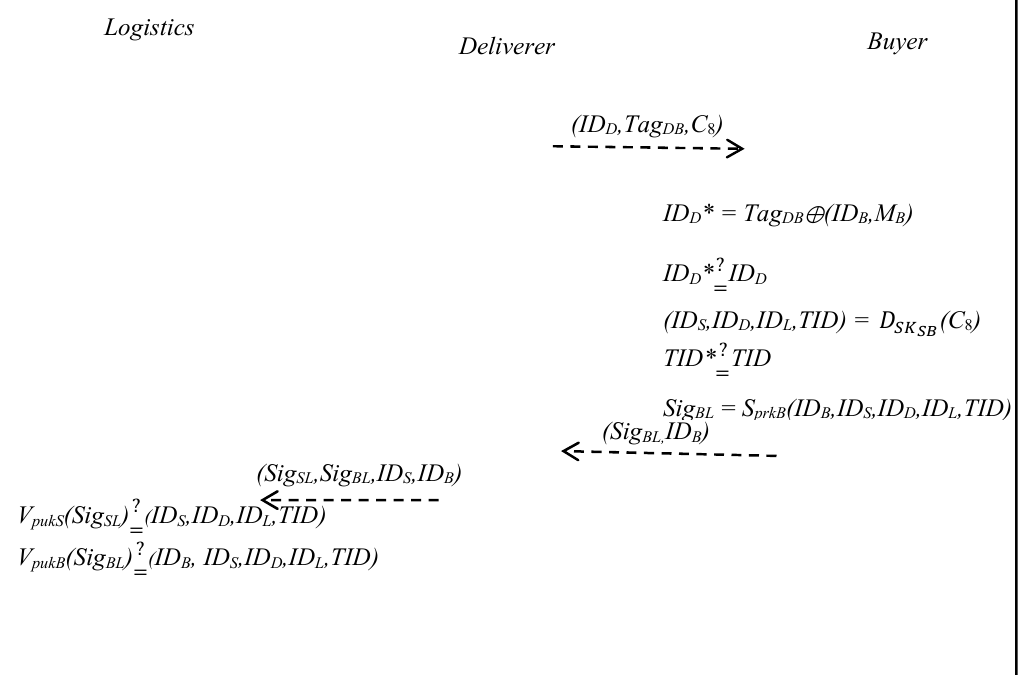
Figure 4. Product transfer phase of the proposed scheme.